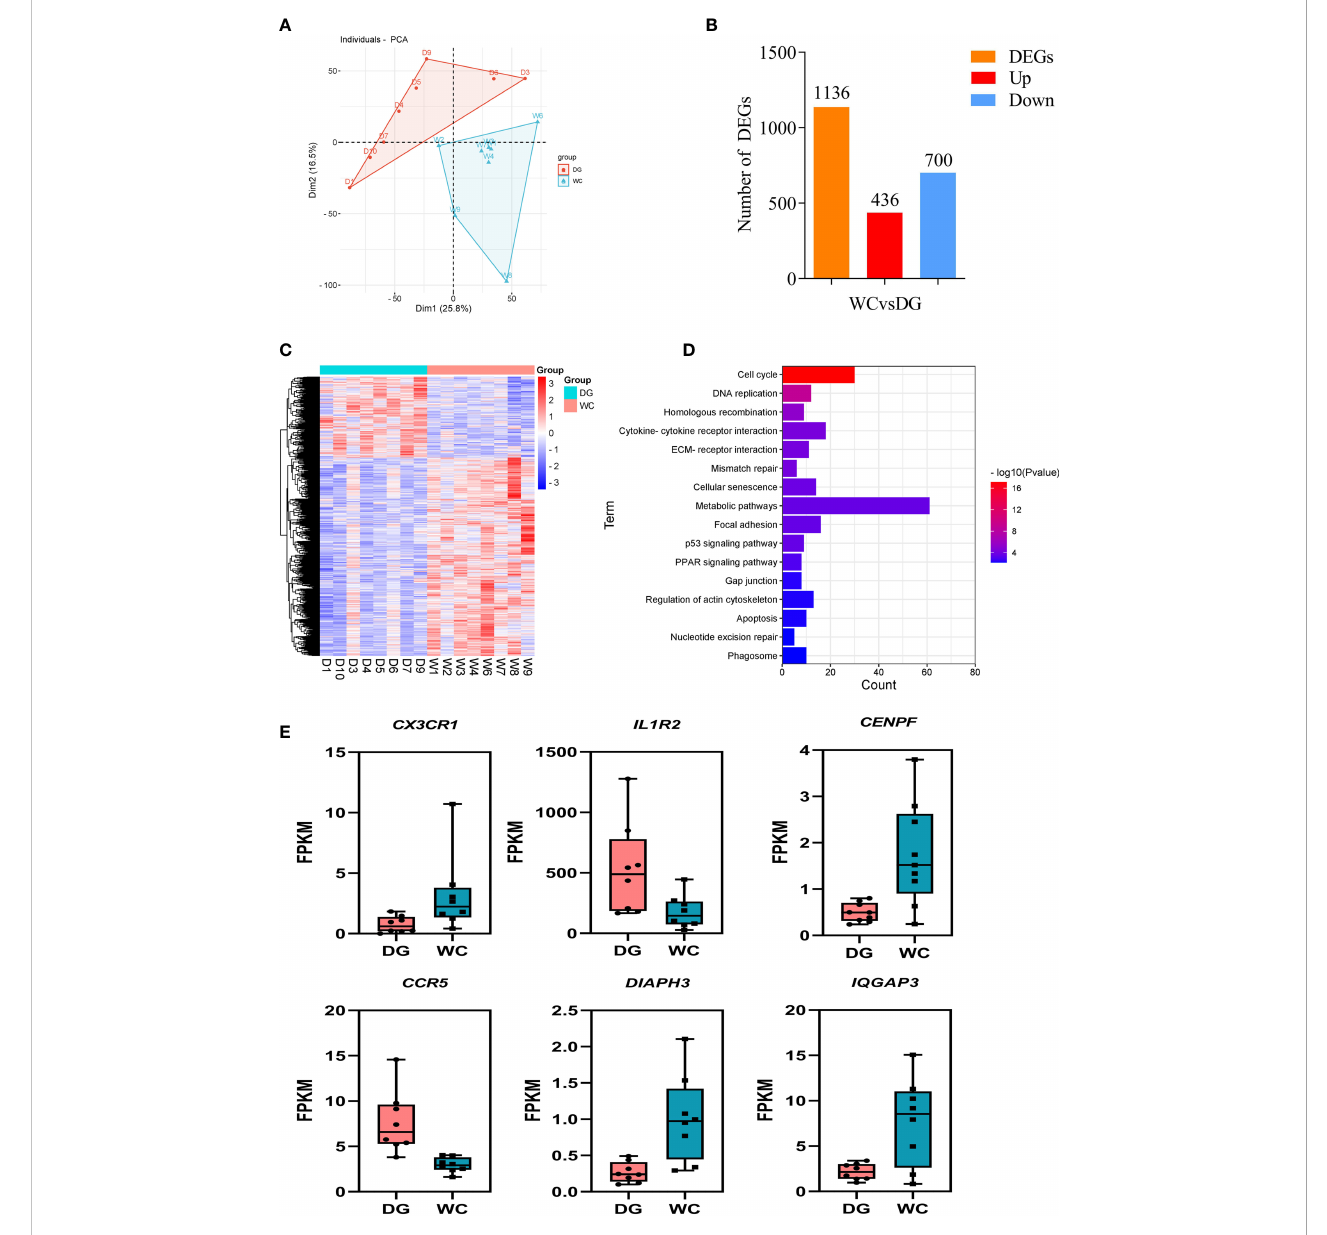
FIGURE 3 Differential expression analysis of macrophages in peripheral blood between Dagu chickens and Wenchang chickens. (A) Individual-PCA plot of all samples (Dagu chickens n=8; Wenchang chickens n=8). (B) Statistics of differentially expressed genes (DEGs). (C) Heatmap dendrogram based on the FPKM expression values of DEGs. Rows represent DEGs, while columns show samples. (D) Signi fi cant KEGG pathways of functional enrichment analysis among DEGs. (E) FPKM values of six representative DEGs in macrophages of Dagu chickens and Wenchang